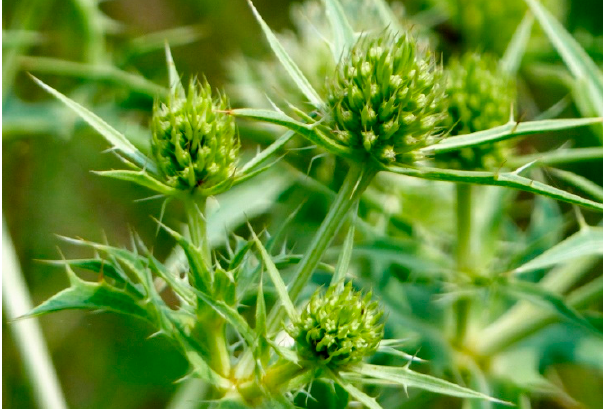
Figure 1. Aerial parts of Erygium campestre.